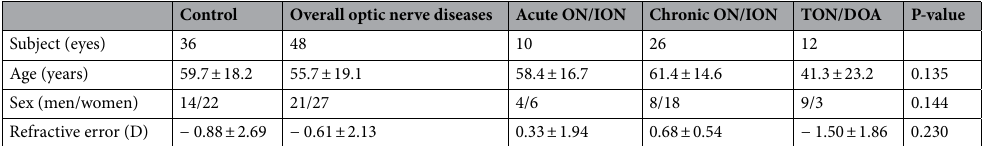
Table 1. Demographics of subjects. Optic nerve disease group were statistically compared with the control group. ON, optic neuritis; ION, ischemic optic neuropathy; TON, traumatic optic neuropathy; DOA, dominant optic atrophy. Data are shown as the mean ± standard deviation.